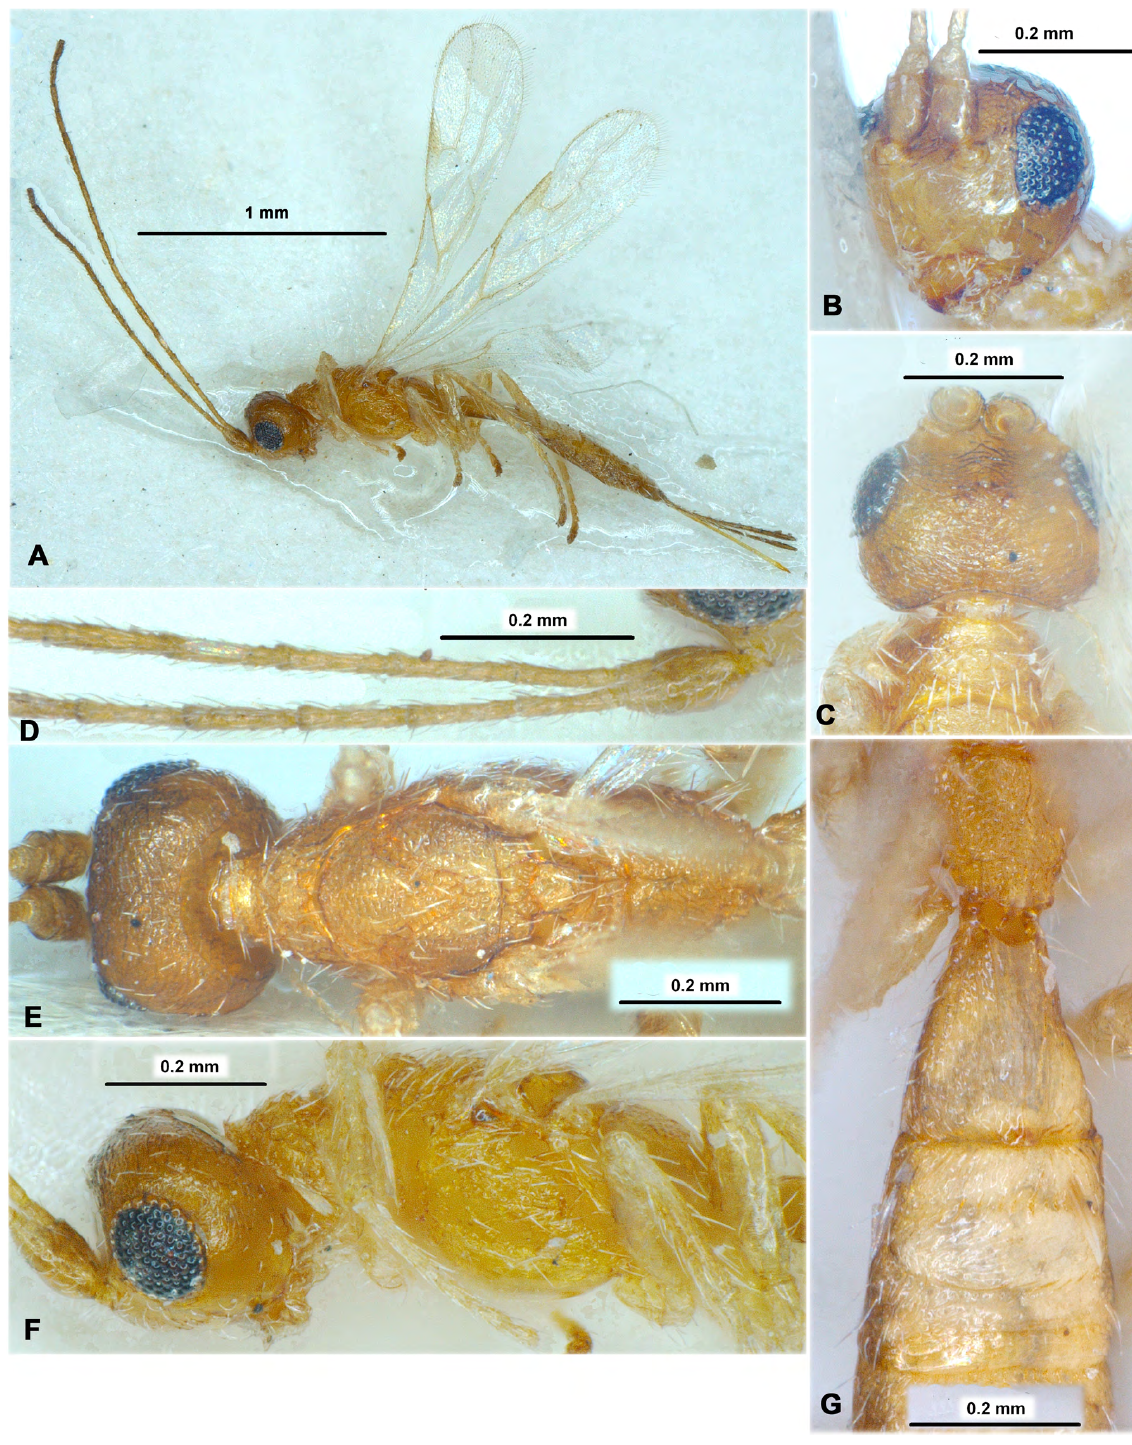
Fig. 40. Rhaconotinus caboverdensis Hedqvist, 1965, ♀, holotype, ZMHU. A . Habitus, lateral view. B . Head, fronto-lateral view. C . Head, dorsal view. D . Basal segments of antenna. E . Head and mesosoma, dorsal view. F . Head and mesosoma, lateral view. G . Propodeum and first to third metasomal tergites, dorsal